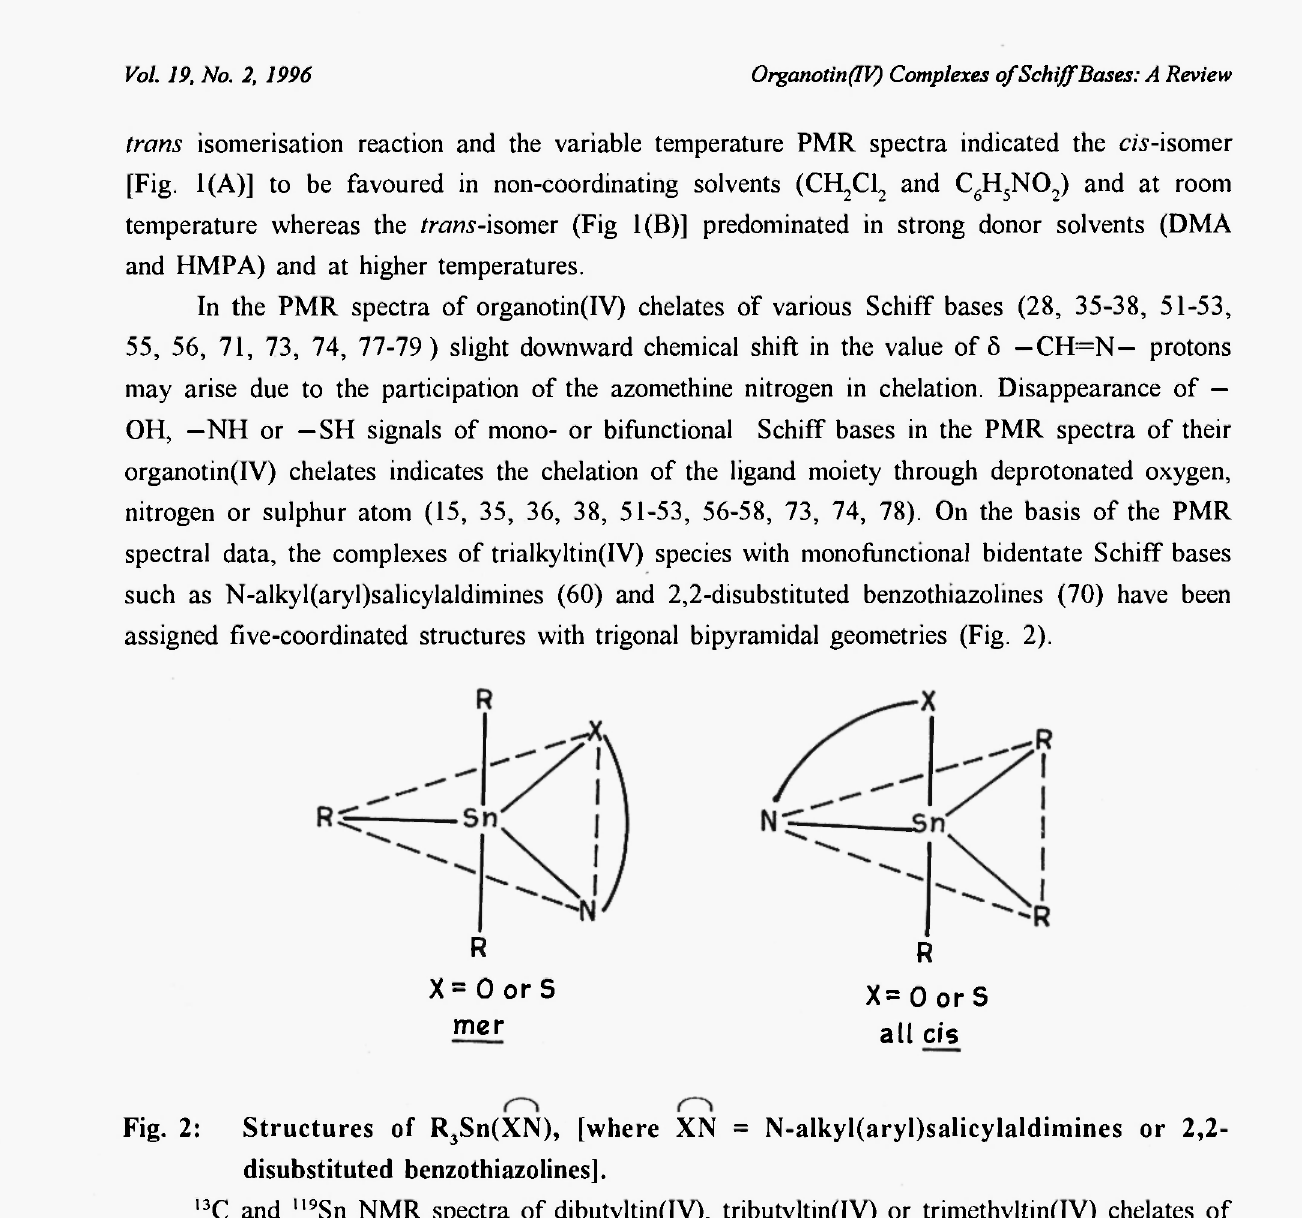
Fig. 2: Structures of R 3 Sn(XN), [where XN = N-alkyl(aryl)salicylaldimines or 2,2- disubstituted